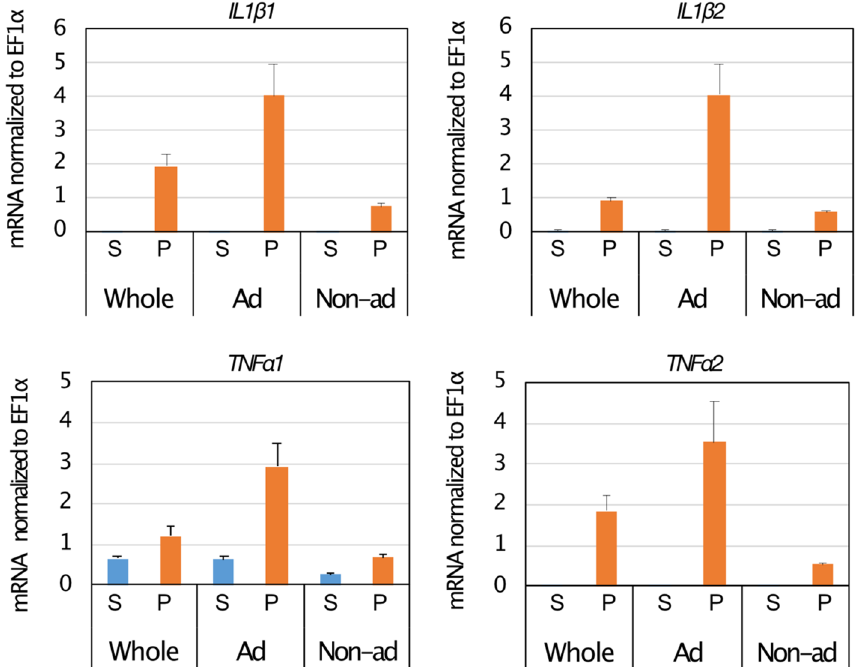
Figure 6. Ex vivo stimulation of eye-sac cells using heat-killed P. aeruginosa cells. The eye-sac cells of bubble- eye goldfish were suspended in medium (see Materials and Methods for details) and pre-incubated at 25 ℃ in 24-well plate (8 × 10 4 /0.8 mL/well) for two hours. Then, adherent (Ad) and non-adherent (Non-ad) cells, were separated by gentle pipetting and cultured. The result from unseparated cell population (Ad + Non-ad; Whole) are also shown in the panels. Gene expressions of pro-inflammatory cytokines in response to heat-killed P. aeruginosa (P) or saline (S) (four hours after adding of the Pseudomonas cells or saline into the culture media) are shown in the figure. The values were normalized to